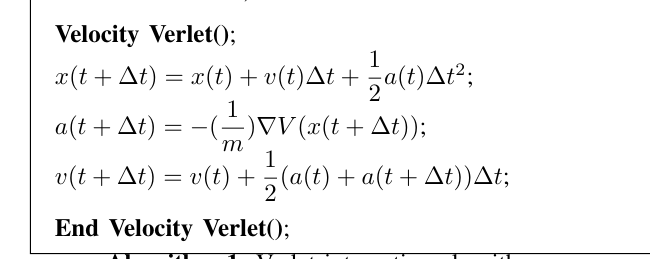
Algorithm 1: Verlet integration algorithm.